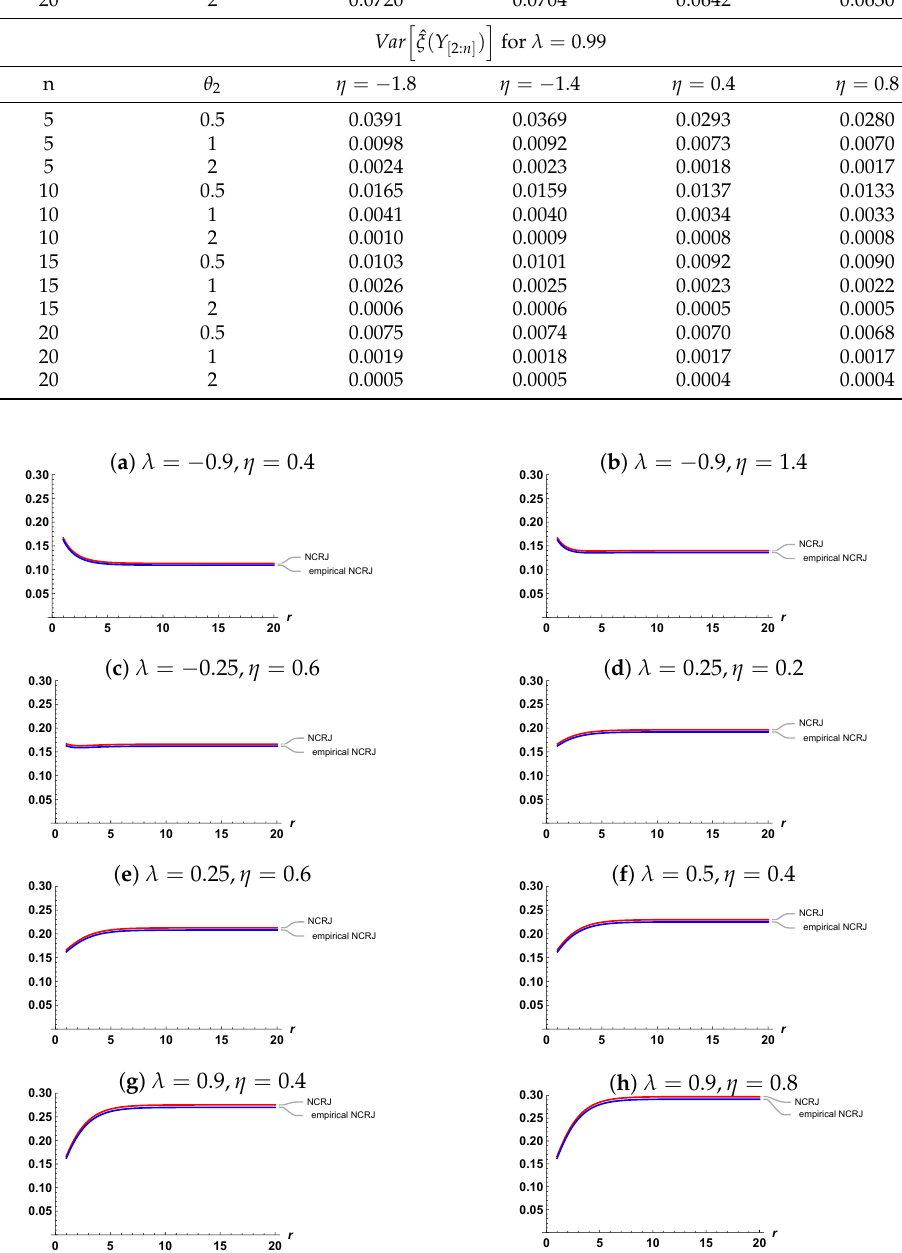
Figure 1. Representation of NCRJ and empirical NCRJ based on R [ r ] from